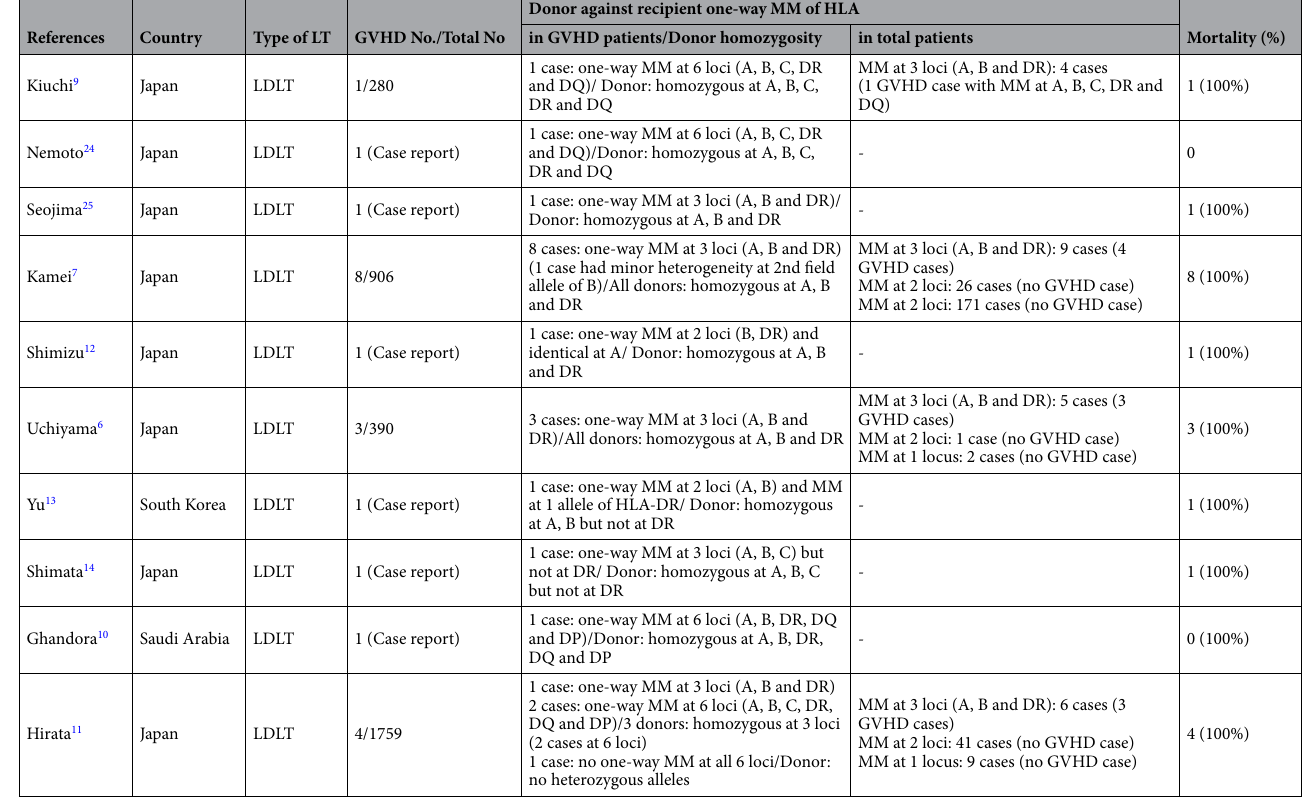
Table 7. Previous studies about HLA one-way mismatches and GVHD after liver transplantation. GVHD, graft versus host disease; HLA, human leukocyte antigen; LDLT, living donor liver transplantation; MM,